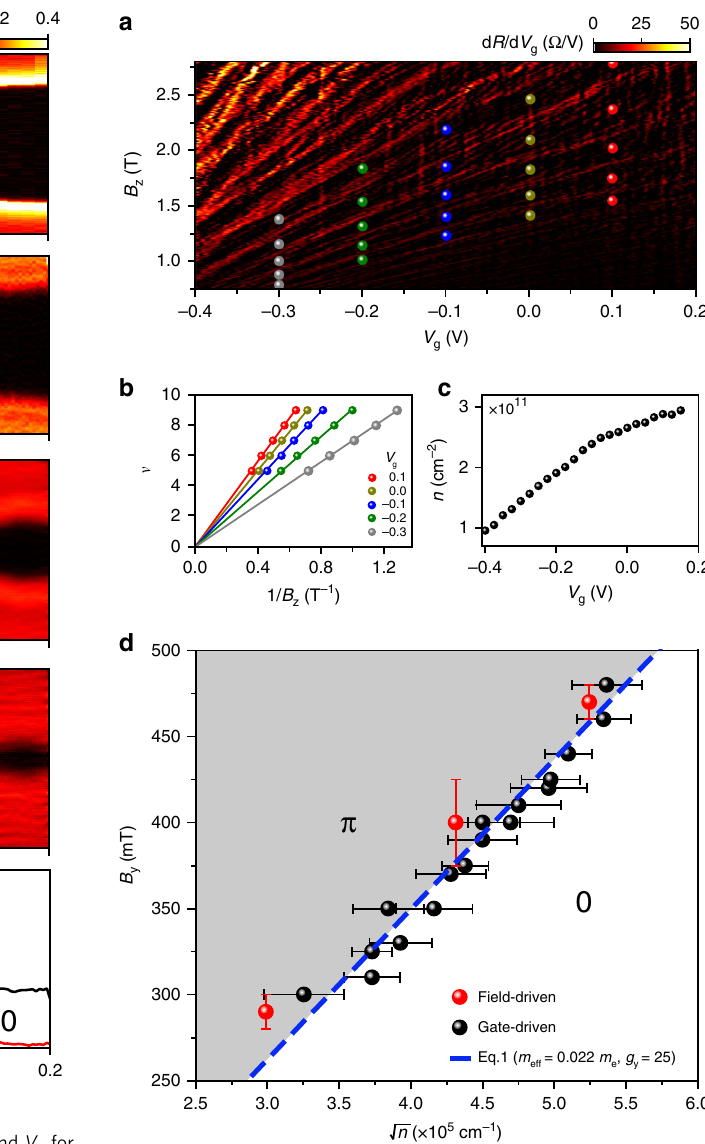
Fig. 4 0 − π phase diagram. a Landau fan diagram for the JJ with L = 1.1 μ m, showing the transresistance (d R /d V g ) as a function of B z and V g . The symbols indicate positions of integer fi lling factors ν at speci fi c values of V g . b Dependence of ν on 1/ B z along with linear fi ts used to extract the electron density, n ( V g ), presented in c . d Phase diagram of the 0 − π transition as a ffiffiffi p / E function of B y ∝ E Z and n , containing all data points obtained from Th both fi eld-driven (red) and gate-driven (black) 0 − π transitions. For the error analysis, see Supplementary Note 6. We fi t the data to Eq. (1) (blue line) with g y as a fi tting Construction of the 0 – π phase diagram . In contrast to the fi eld- driven measurements (Fig. 2), controlling the transition with a gate avoids the need for time-consuming fi eld alignment proce- dures, thus allowing us to ef fi ciently explore a large parameter space in magnetic fi eld and gate voltage. We now combine these results to construct a 0 – π phase diagram of the JJ. The combi- nation of a high quality 2DEG and relatively long devices results in well de fi ned magneto-resistance oscillations, allowing us to directly extract the electron density in the junction. Figure 4a shows the Landau fan diagram in perpendicular magnetic fi elds, B z , from which we identify the fi lling factors, ν = nh / eB z (Fig. 4b),